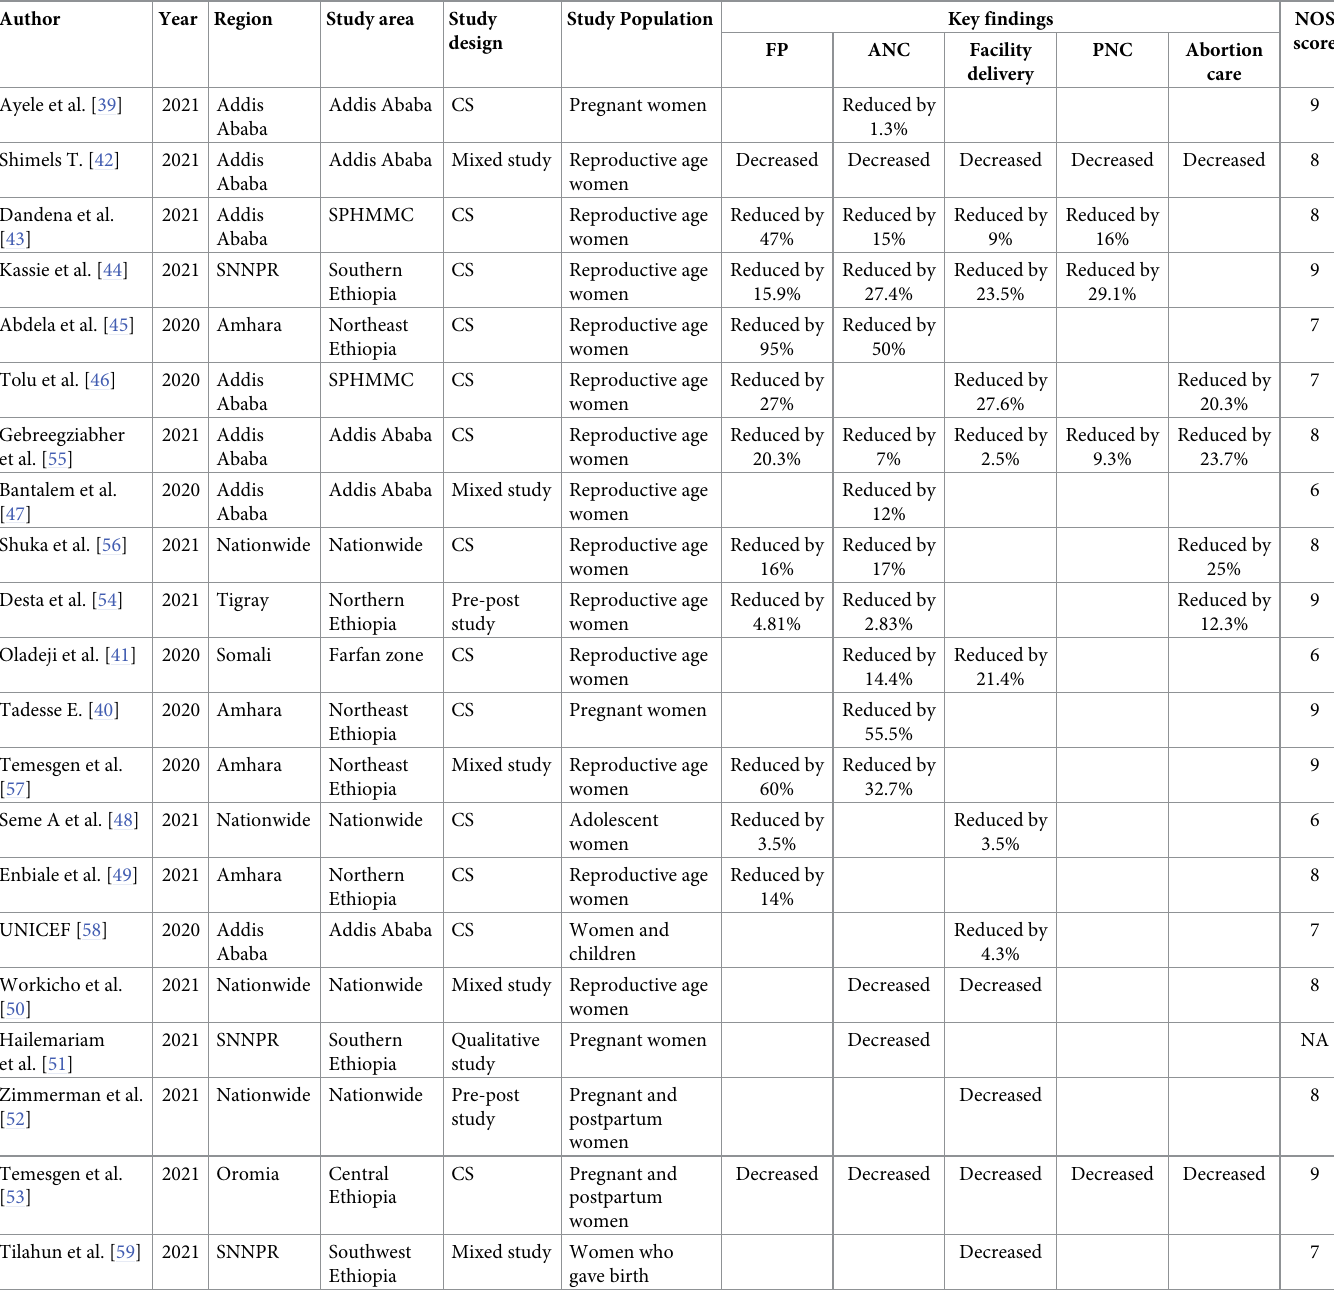
Table 1. Description of studies on the impact of the COVID-19 pandemic on the utilization of maternal healthcare services in Ethiopia,